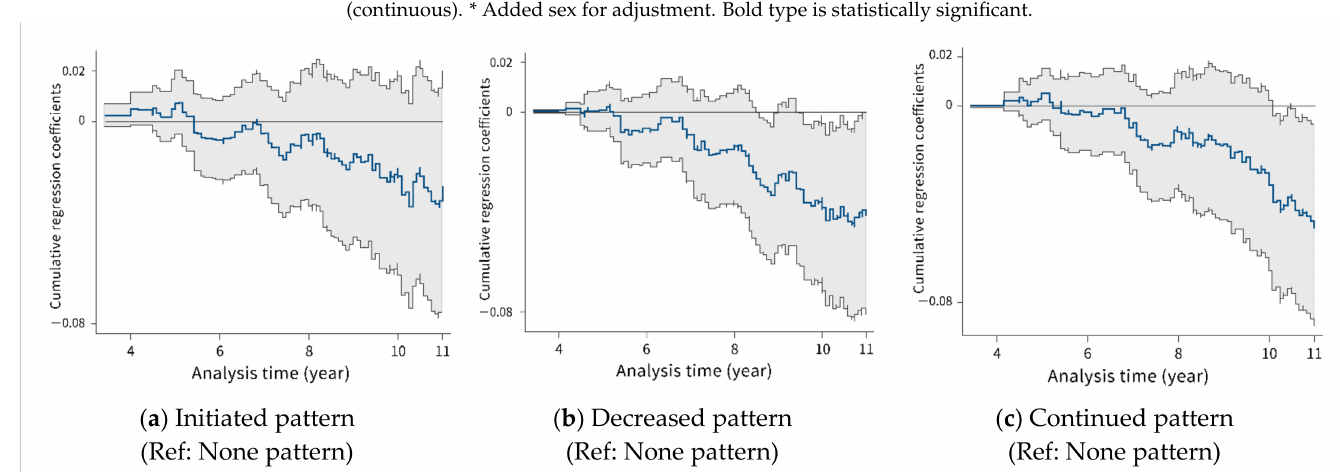
Figure 2. Plot of the estimated cumulative regression coefficient for the changes in the frequency of the pattern of social participation with a 95% confidence interval based on Aalen’s linear hazards model *: ( a ) Initiated pattern; ( b ) Decreased pattern; ( c ) Continued pattern. * Performed a multivariate model before imputing the